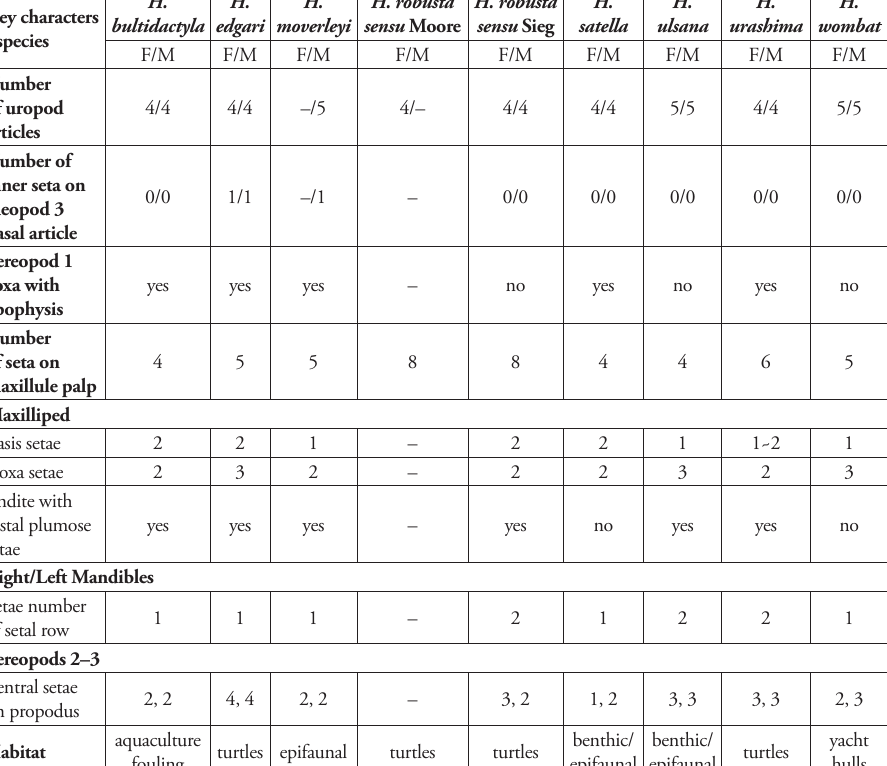
Table 1. Morphological comparison between nine species within the genus Hexapleomera. Key characters \